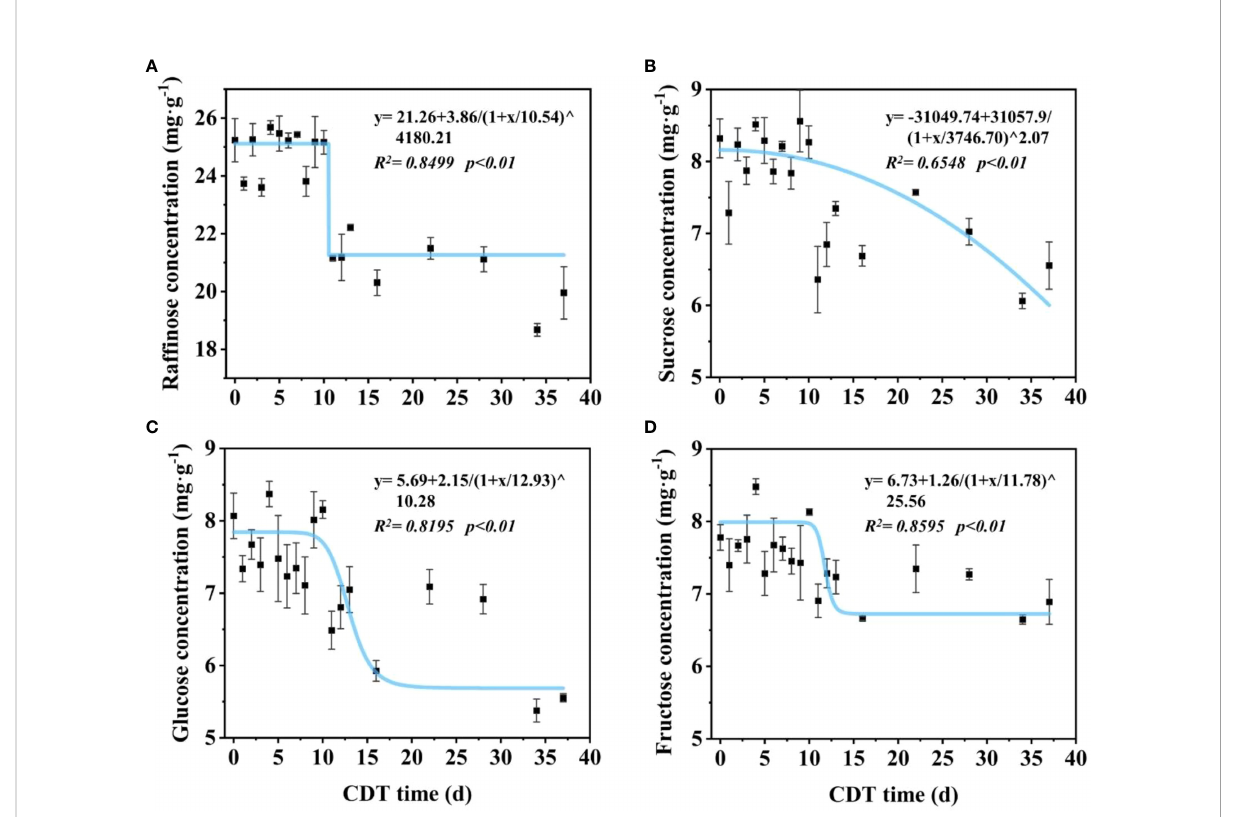
FIGURE 2 Effects of aging days on the concentration of raf fi nose (A) , sucrose (B) , glucose (C) , and fructose (D) in saf fl ower seeds. The curve was simulated according to the logistic function. Seeds were sampled on aged 0 – 13, 16, 22, 28, 34, and 37 days. Each symbol represents the average of three replicates ± SE. CDT, controlled deterioration